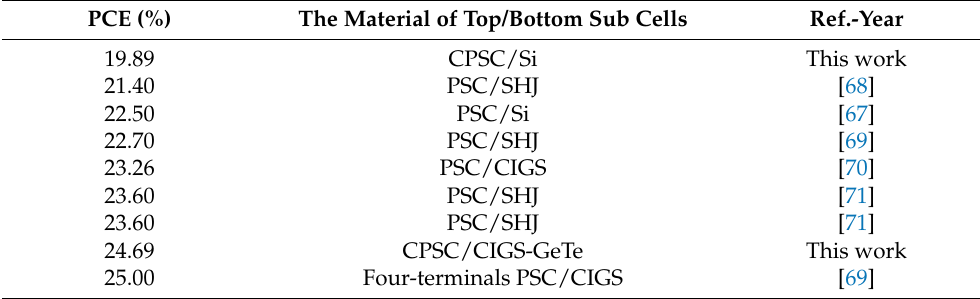
Table 4. A comparison of the proposed tandem solar cells with the recently published data. PCE (%)